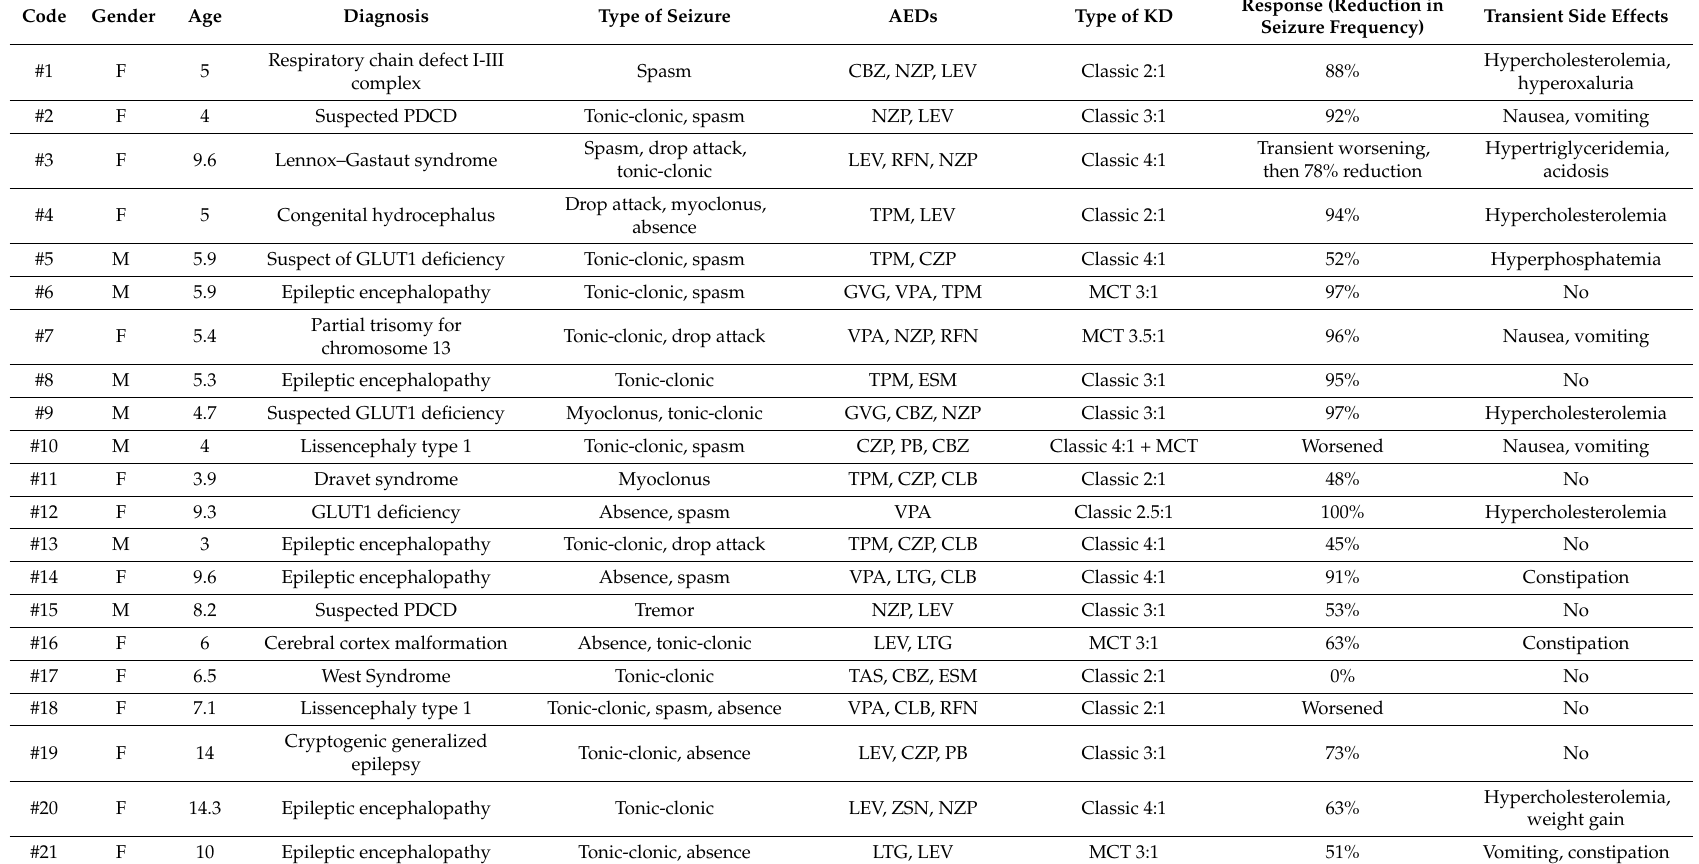
Table 1. Demographic and clinical features of patients treated with the ketogenic diet (KD). Abbreviations: AEDs, antiepileptic drugs; CBZ, carbamazepine; CLB, clobazam; CZP, clonazepam; ESM, ethosuximide; GVG, vigabatrin; LEV, levetiracetam; LTG, lamotrigine; NZP, nitrazepam; PB, phenobarbital; PCDC,